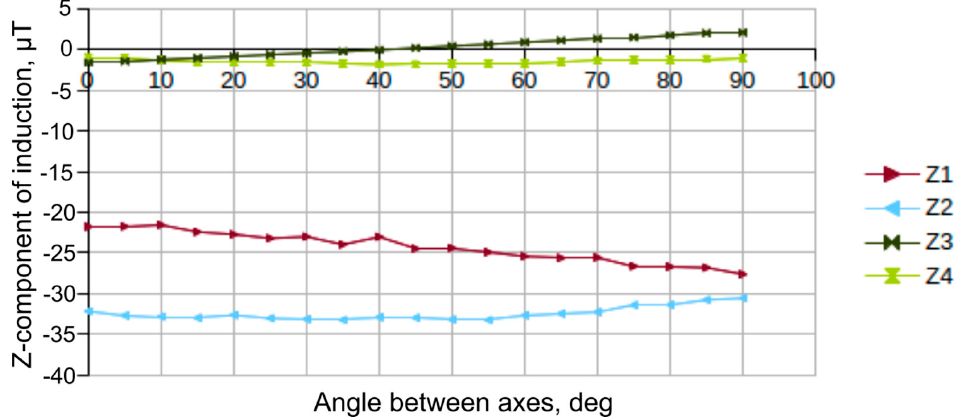
Figure 5. Dependence of the magnetic induction vector "Z" component in the cores of magneto- sensitive ("Z1"–"Z4" curves correspond to "D1"–"D4" elements).